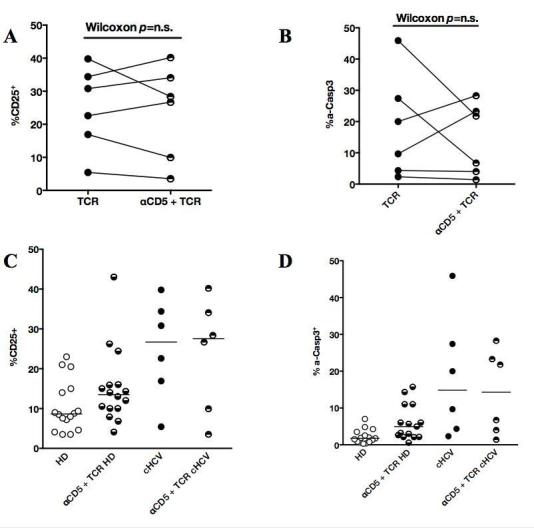
Impact of CD5 blockade on TCR activation profile in cHCV patients.(A and B) Impact of preincubation with anti-CD5 antibodies on% CD25 and% active-caspase 3 after CD3/28 stimulation in cHCV patients. (C and D) Summary of impact of anti-CD5 on HD and cHCV patients.